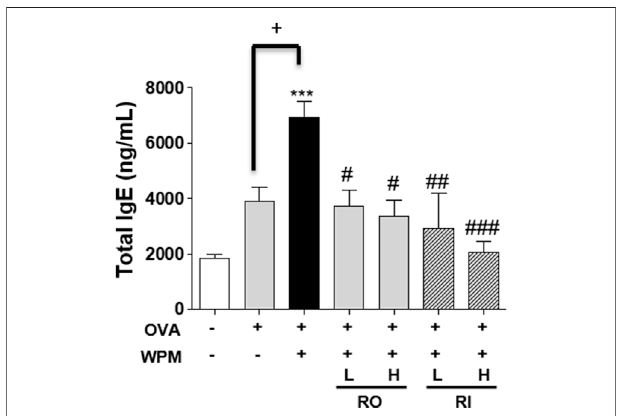
FIGURE 4 | The effects of RL on allergic response in a WPM- exacerbated mouse model of asthma. The total IgE levels in serum were analyzed by ELISA. All data are presented as the mean ± SEM. n = 4/group. *** p < 0.001 compared with the control group; # p < 0.05, ## p < 0.005 and ### p < 0.001comparedwiththeOVA+WPMgroup; + p < 0.05compared with the OVA